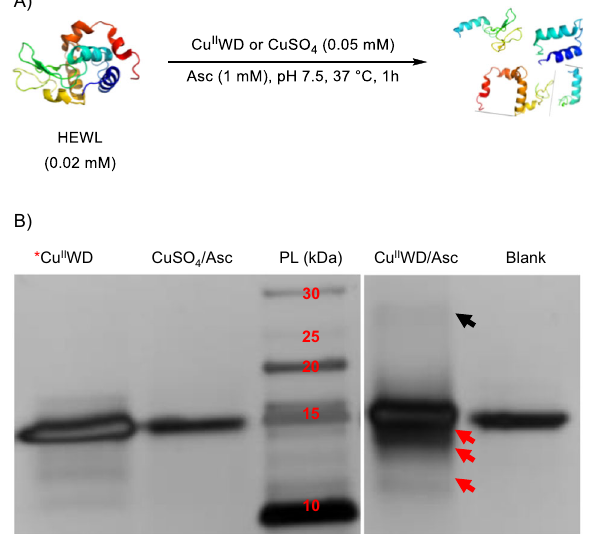
Fig. 1 | Cleavage of HEWL catalyzed by Cu II WD/Asc. A Equation shows the oxi- dativecleavageofHEWL(0.02mM)inpresenceofAsc(1mM)andCu II WDorCuSO 4 (0.05mM)atpH7.5and37°Cfor1h; B SilverstainedSDS-PAGEgeloftheoxidative cleavage of HEWL (0.02mM) in presence of Asc (1mM) and Cu II WD or CuSO 4 (0.05mM) at pH 7.5 and 37°C for 1h. Red arrows indicate HEWL bands generated. The black arrow indicates the bands from HEWL dimerization. PL; protein ladder. *Hydrolytic cleavage of HEWL (0.02mM) in presence of Cu II WD (2mM) at pH 7.5 and60°Cfor3days.Allexperimentswererepeatedindependentlythreetimesand provided similar results. Source data are provided as a Source Data fi